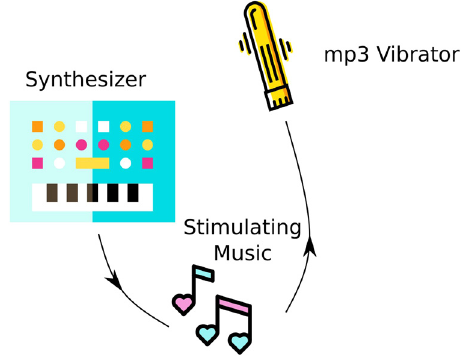
Figure 1: Music - controlled vibrator.